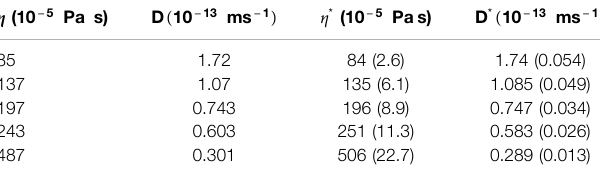
TABLE 2 | The fi rst column is the viscosity of the glycerol-water solution ( fi rst row only water) as measured in a classical rheometer, while the second column is thediffusioncoef fi cient.Thethirdcolumnprovidestheviscosityvaluesasobtained in our experiment using Eq. 9 , while the fourth column again shows the diffusion coef fi cient for our case. The standard errors are noted in parentheses.